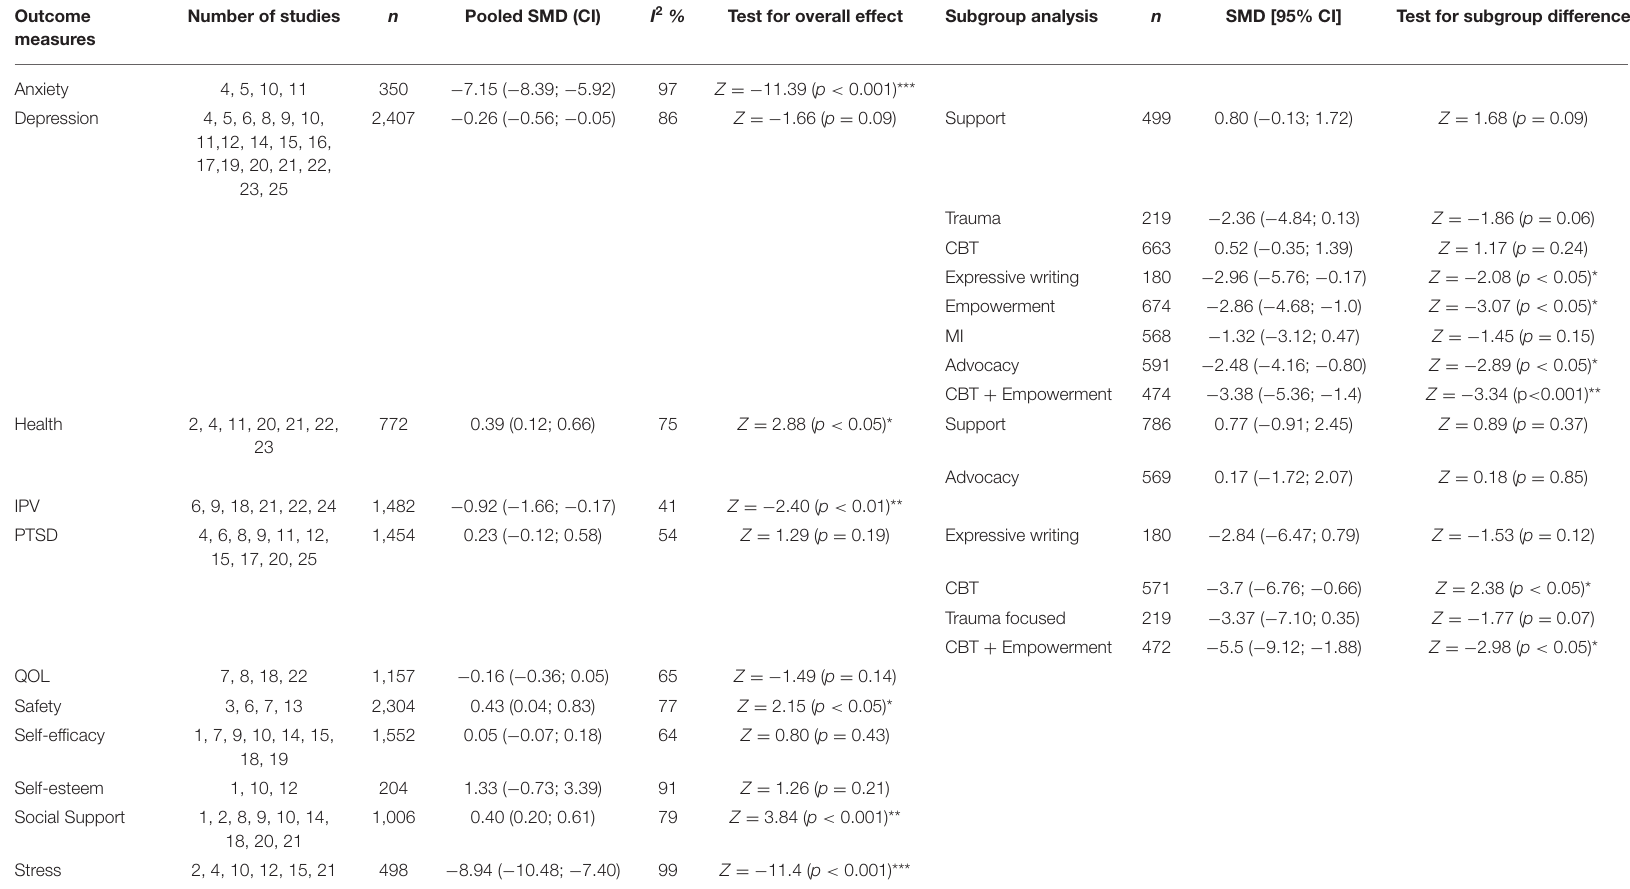
TABLE 1 | Results for meta-analysis and subgroup analysis in the meta-analysis for treatments for female victims of intimate partner